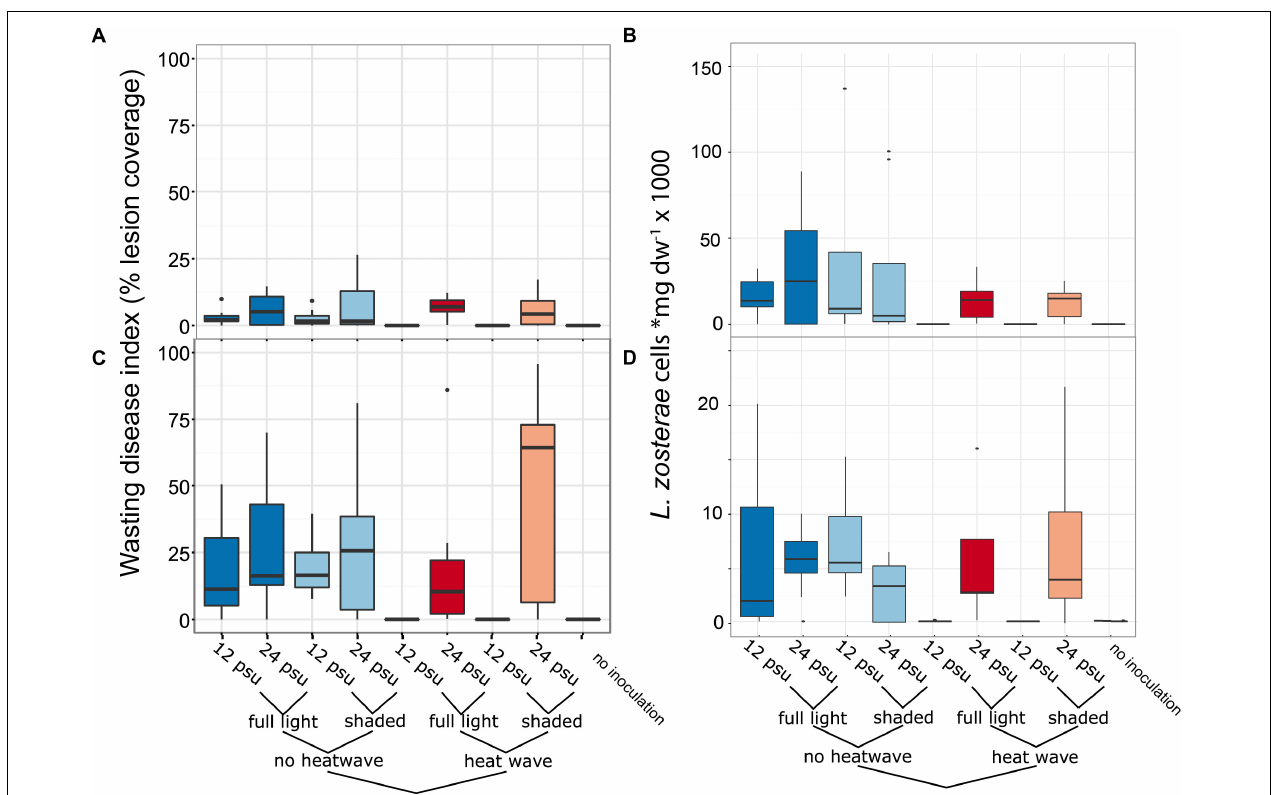
FIGURE 3 | Box plots of L. zosterae abundance as function of the multi-stressor treatment. Upper panels show abundance 2-days post inoculation as (A) necrotic lesion area (% lesion coverage) and (B) L. zosterae cell abundance (as mg dry weight leaf tissue − 1 ) determined by Taqman based RT-qPCR assay. Panels (C,D) : same response variables 8 days post inoculation. Inoculation control includes samples without L. zosterae inoculation from all treatments. The x -axis displays the combinatorial structure of the stress treatments. Color codes are corresponding to the ones used in Figure 6